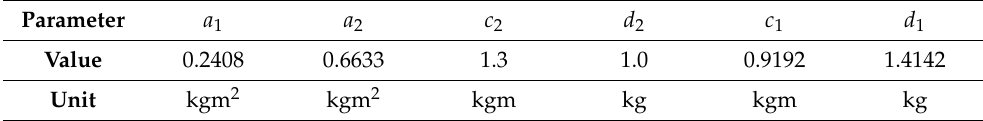
Table 3. Numerical values of the coefficients defined in properties